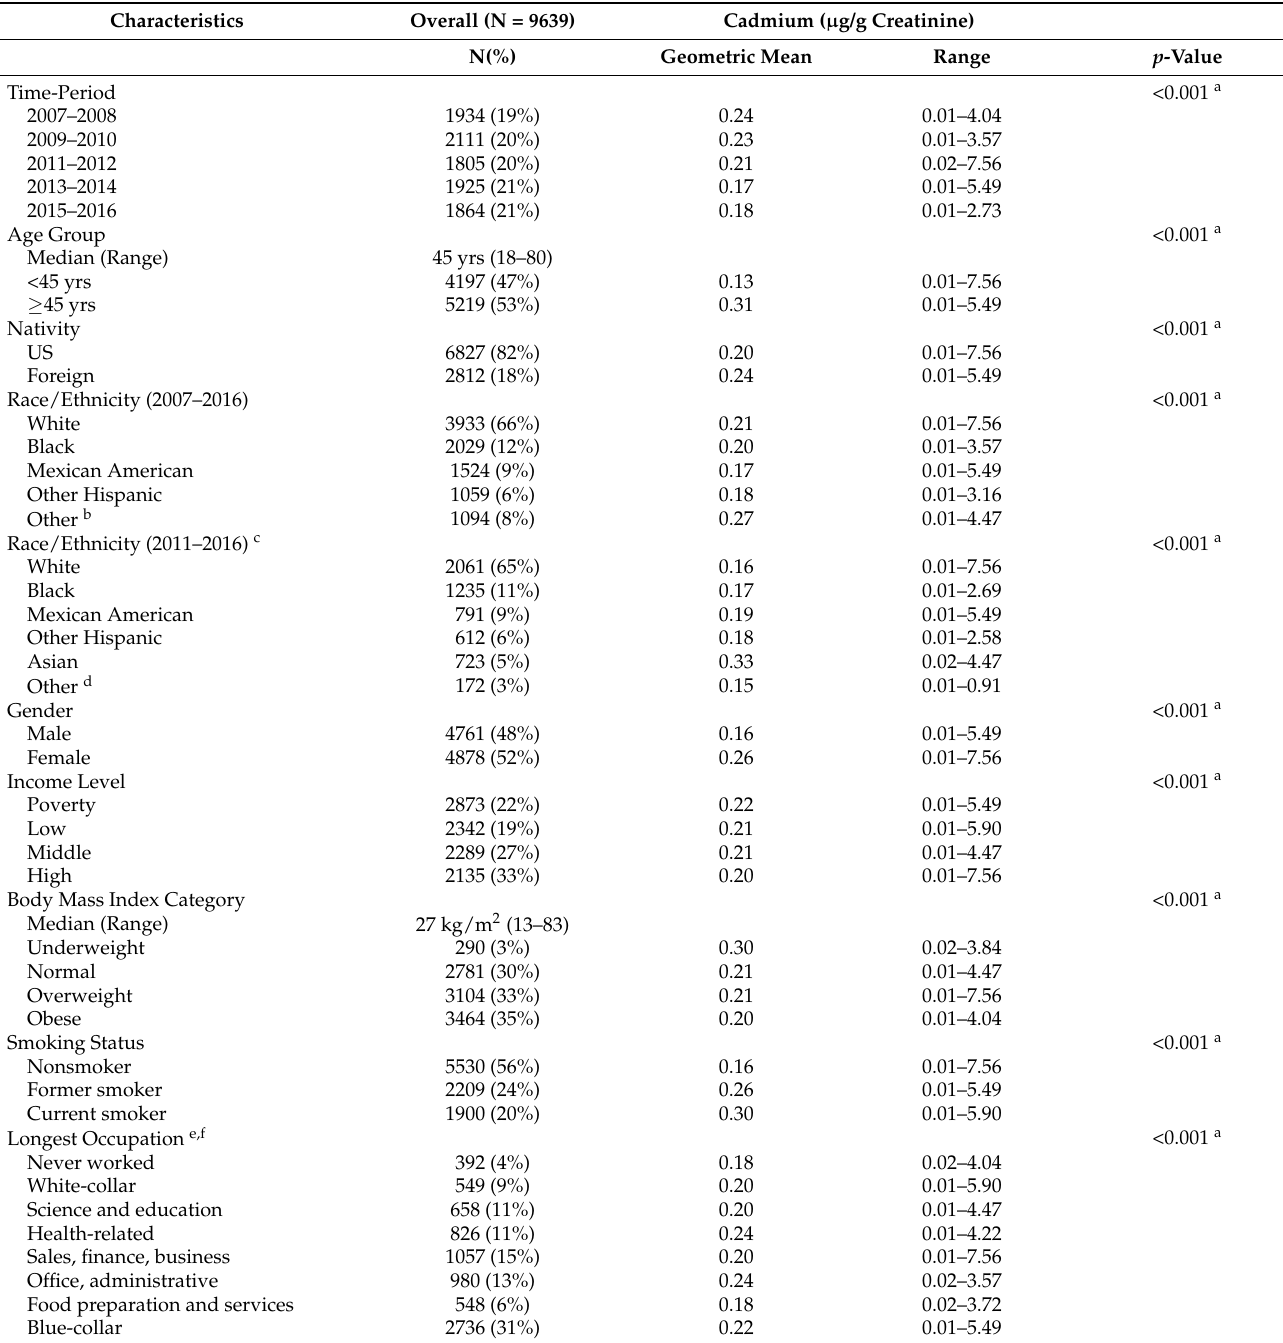
Table 2. Association between the patients’ characteristics and geometric mean values of urinary cadmium